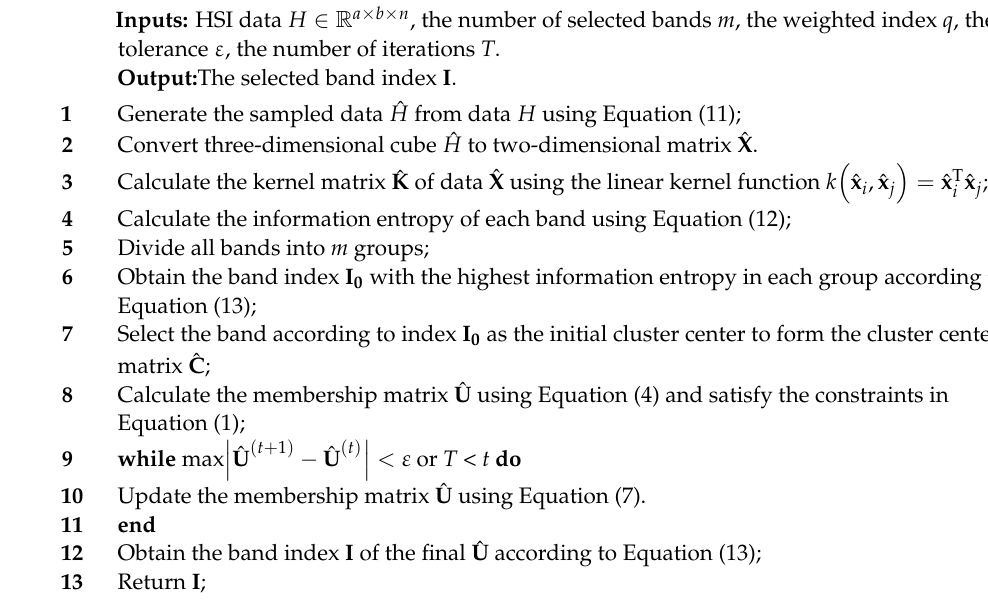
Algorithm 1: Procedure of